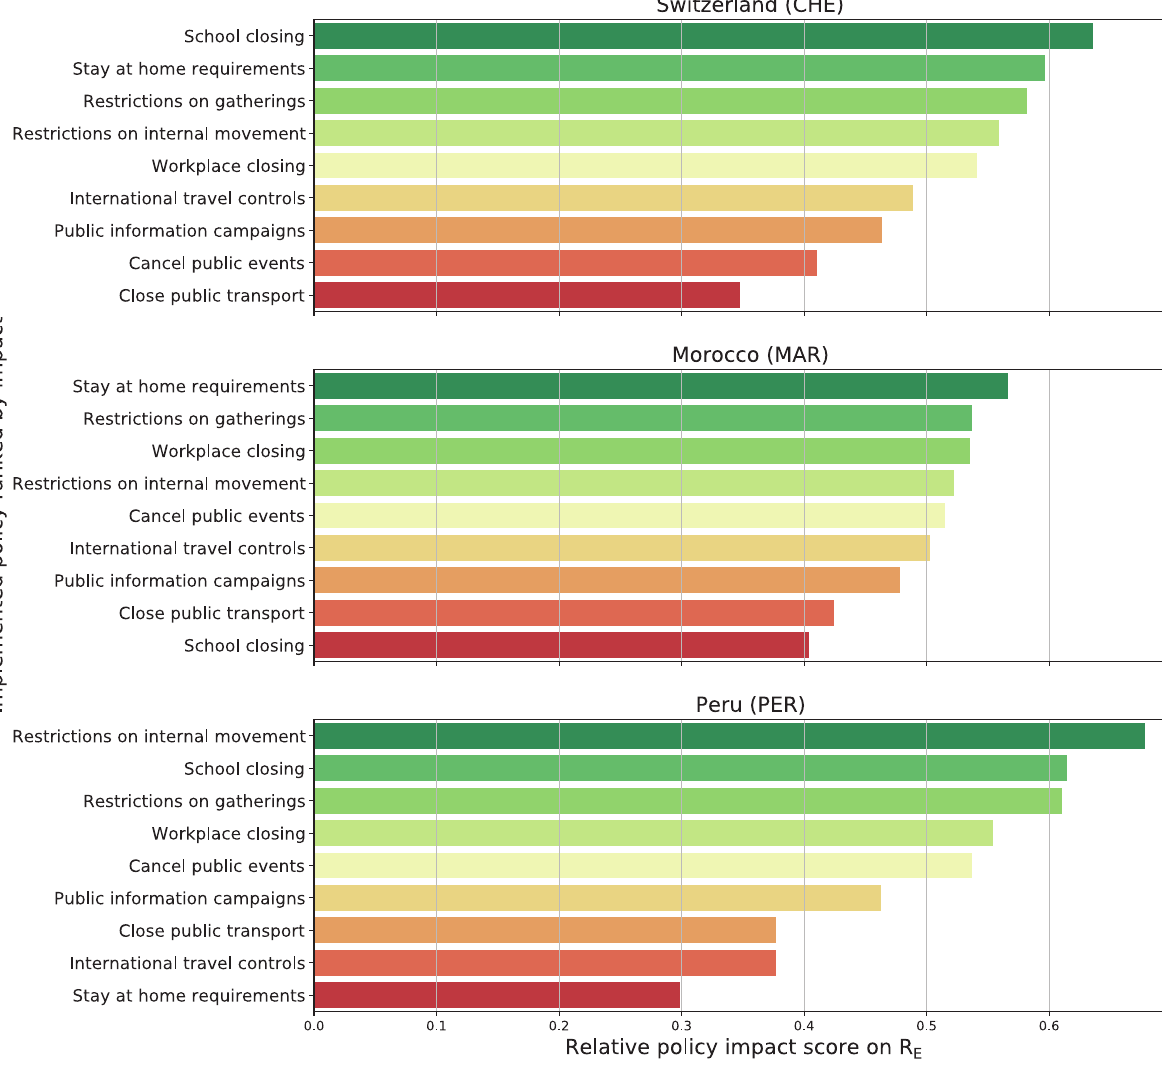
Fig 5. Policy impact for three sample countries. Relative policy impact for (top to bottom) Switzerland, Morocco and Peru. An high impact score (green bars) is associated to a reduction of the R E .